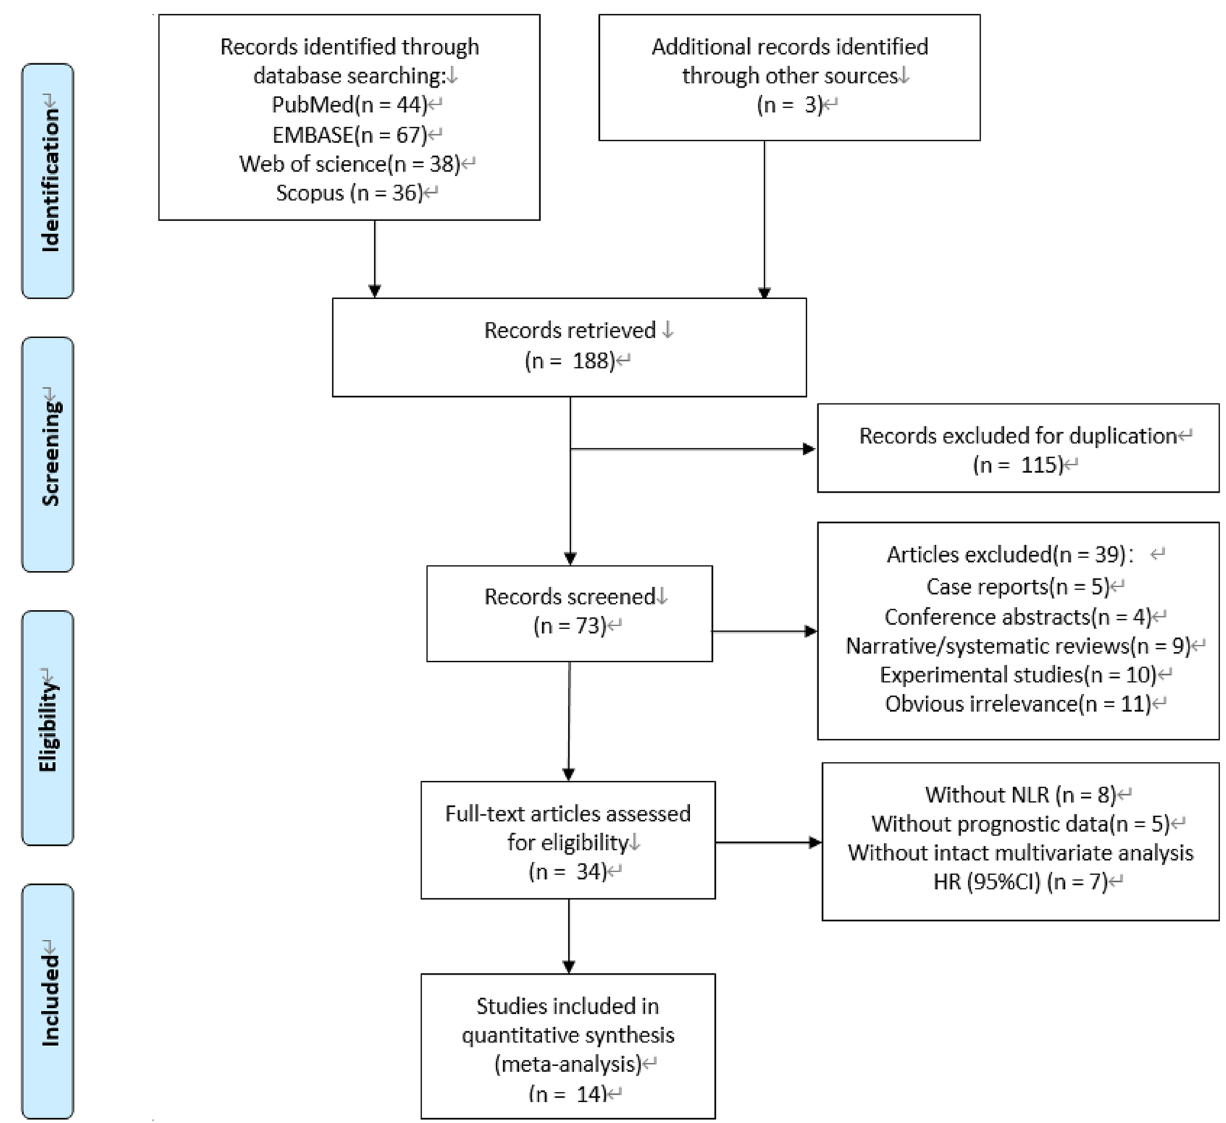
Figure 1. Search strategy and the flowchart of included